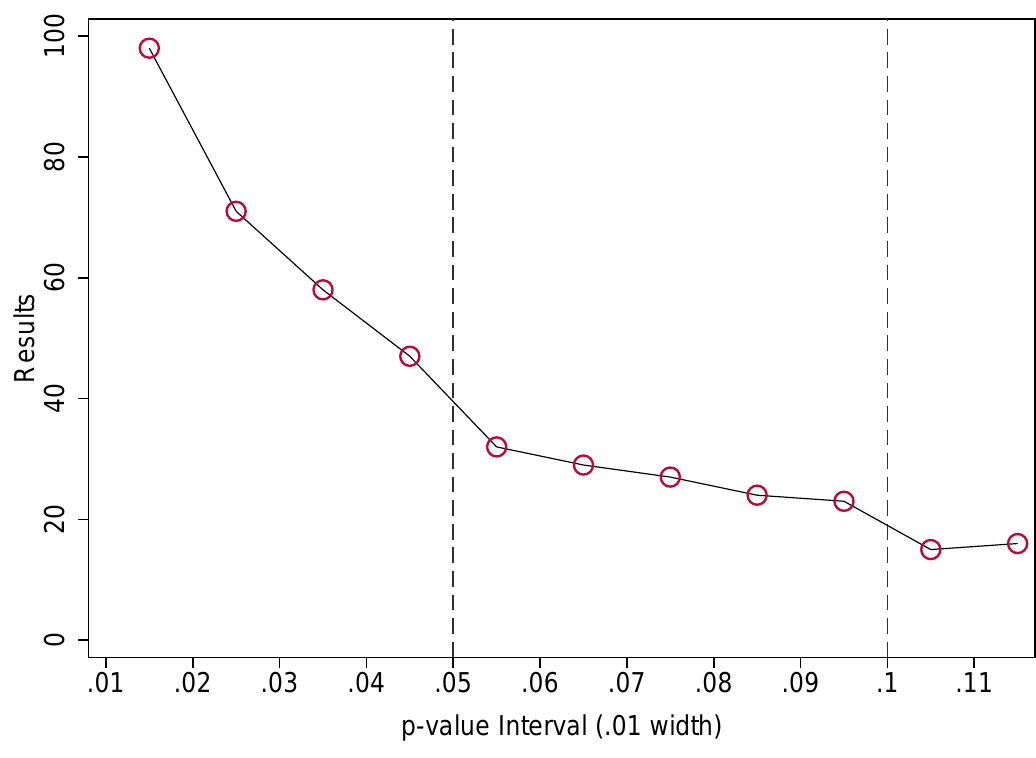
Figure 1: Estimated p -values of study results reported in two studies of publication bias in